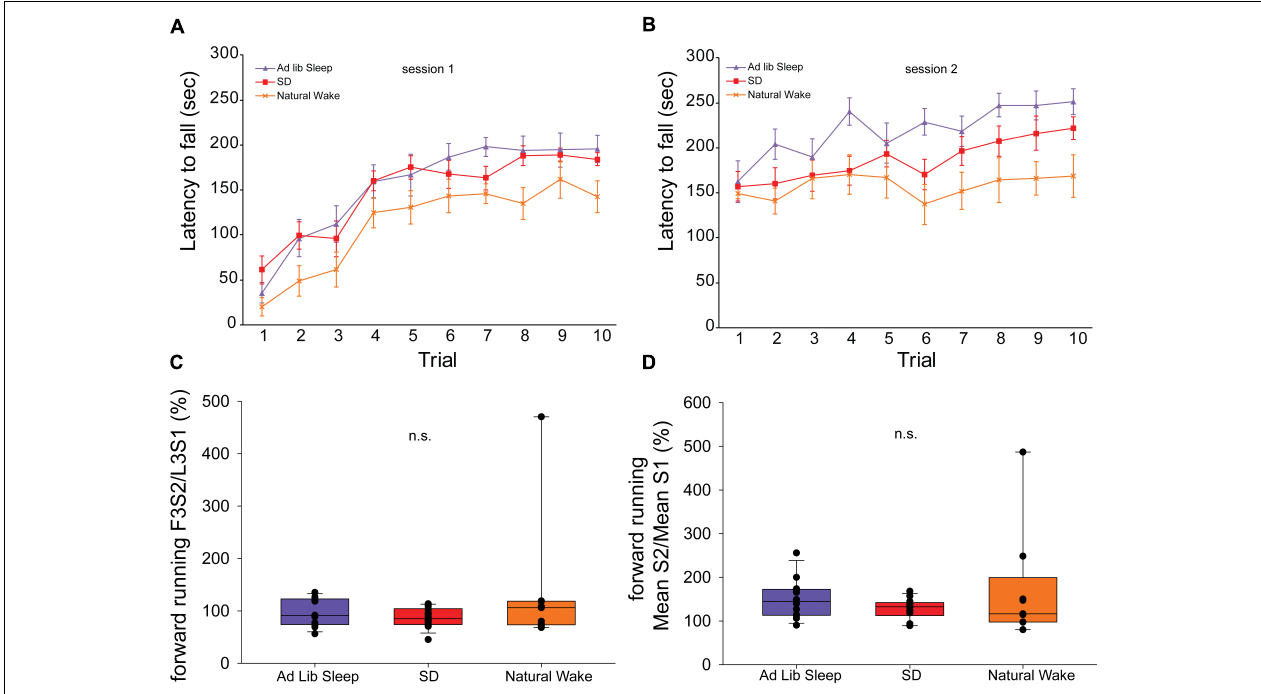
FIGURE 4 | Rotarod performance during exclusive forward running template behavior. Latency to fall on 10 consecutive trials of the exclusive forward running template behavior during session 1 (A) and session 2 (B) . Measures of offline change in performance in the first 3 trials of session 2 normalized to performance in the last 3 trials of session 1 (F3S2/L3S1) (C) as well as the mean performance in session 2 normalized to the mean performance in session 1 (mean S2/mean S1) (D) show no effect of sleep